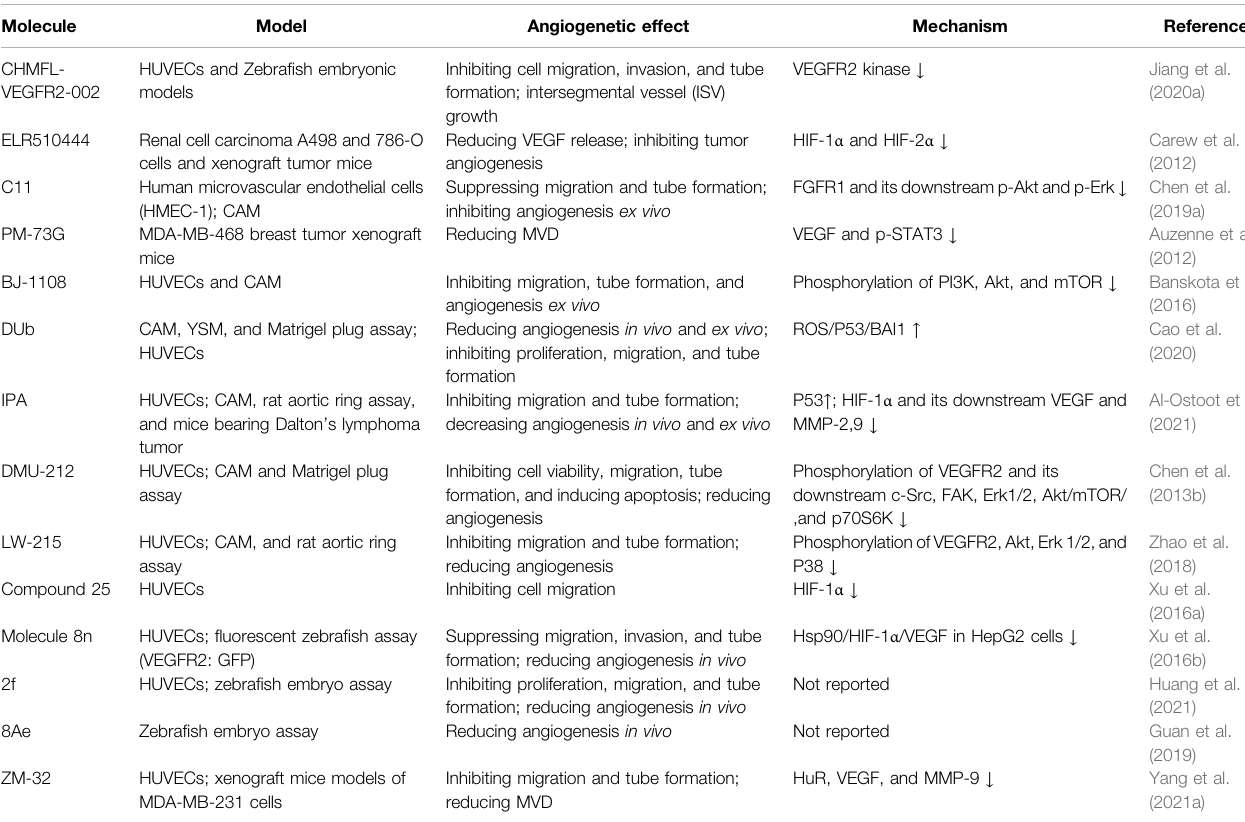
TABLE 2 | Anti-angiogenic effects and mechanisms of compounds related to ethnopharmacology.